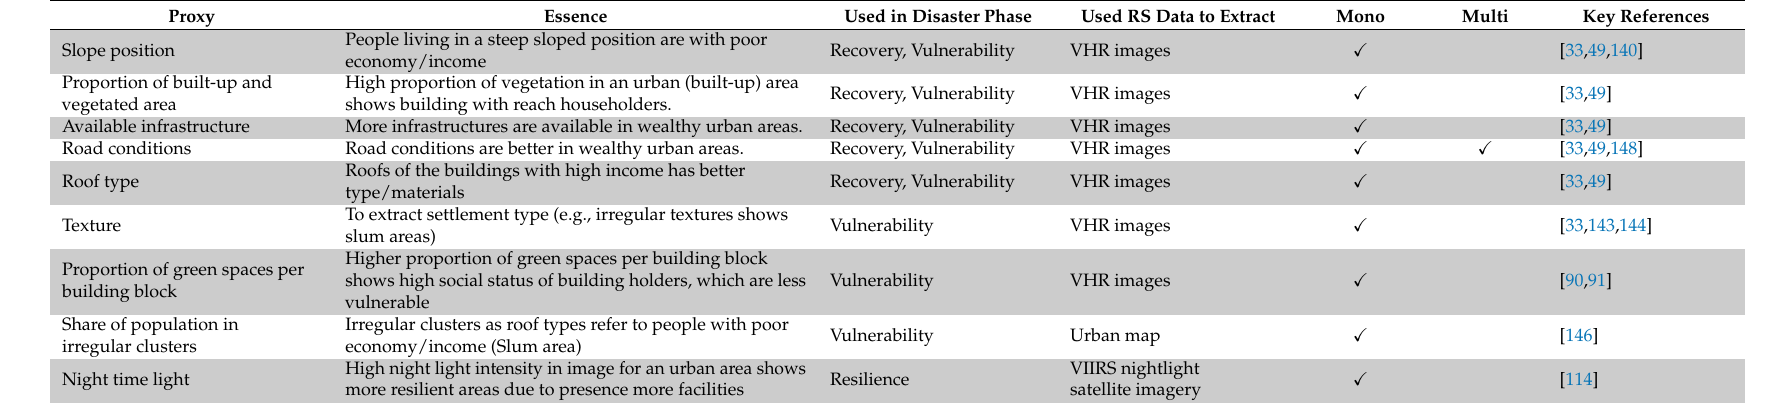
Table 7. Remote sensing-based social proxies for urban DRM, Socio-economic status category. Mono and Multi refer to mono-temporal and multi-temporal RS data that used for extraction,